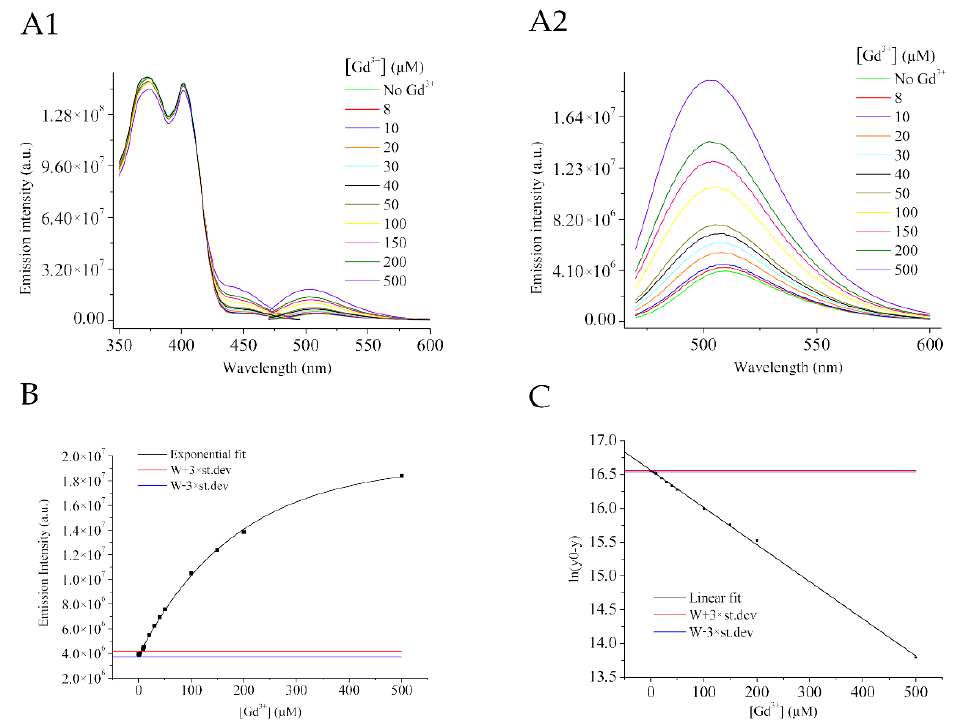
Figure 3. ( A1 ) Excitation and emission spectra at different Gd 3+ concentrations. ( A2 ) Magnification of the emission spectra. ( B ) Emission intensity at different Gd 3+ concentrations. ( C ) Linearized fitting of data reported in ( B ). (pH = 6.1 ± 0.1).